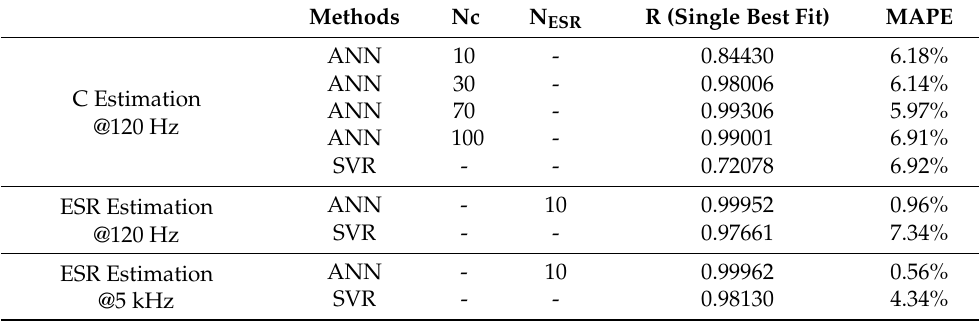
Table 2. Fitting results from experimental data.